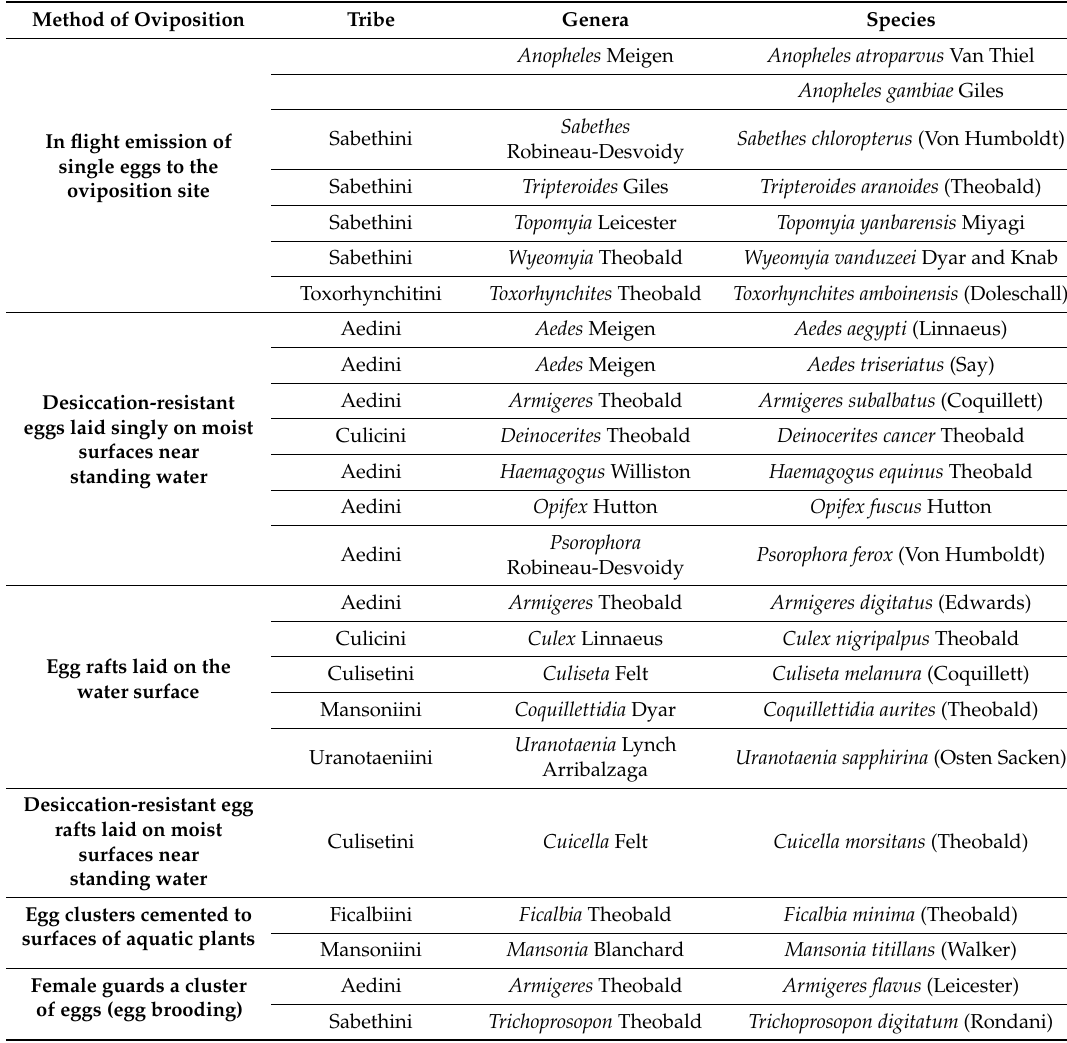
Table 1. Mosquito oviposition: examples of egg laying behavior